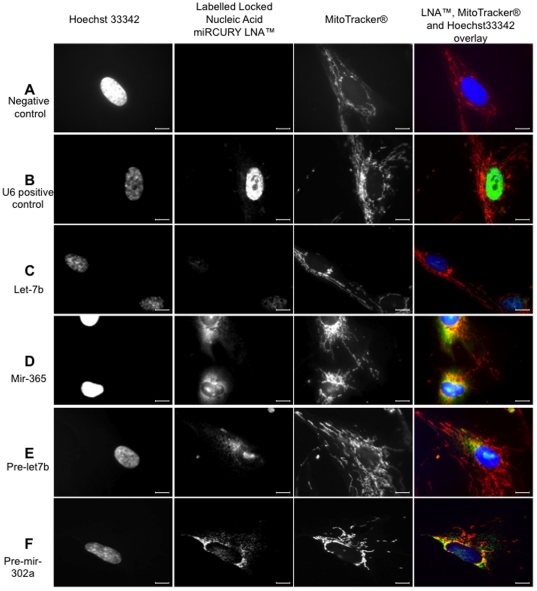

In situ hybridization pattern of digoxigenin-labeled Locked Nucleic Acid (LNA) for specific miR and pre-miR in human skeletal muscle myoblasts cells observed in classic optic microscopy.Using locked nucleic acid (LNA) probes digoxigenin labelled, we determined the in situ hybridization pattern of mir and pre-mir. Hoechst 33342 staining of nuclei (lane 1), specific signal of scramble miRNA (A; negative control), U6 small nuclear RNA (B; positive control), let-7b (C), mir-365 (D), pre-let-7b (E) and pre-mir-302a (F) probes (lane 2) and MitoTracker® Red CM-H2XRos staining of respiring mitochondria (lane 3) are represented in gray scale. All these images were acquired using an Olympus BX61 straight microscope controlled with Metamorph software (Molecular Devices, Downington, PA19335) using a 100× oil-immersion objective. In the overlays (lane 4) provided by Image J software, positive in situ hybridization signals are visualized in green, respiring mitochondria signal in red and nuclei staining in blue. Yellow staining suggests co-localization of LNA probes (green fluorescence) and MitoTracker® Red CM-H2Ros (red fluorescence). Scale bars = 10 µm. Images are not scaled to the same intensity range. Positive in situ hybridization signals were normalized by scramble miR signal intensity (negative control).